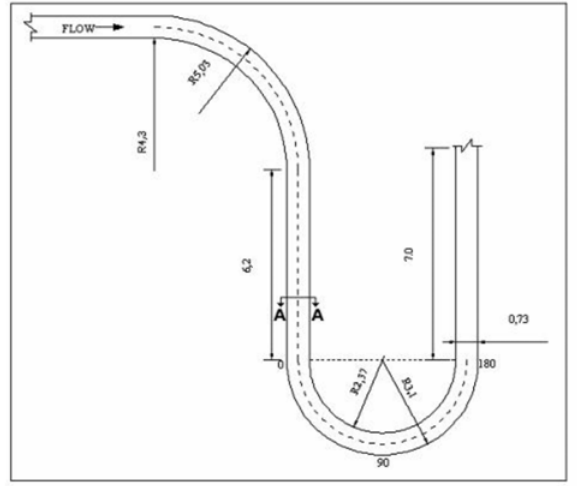
Fig. 1. Plan view of the physical model.